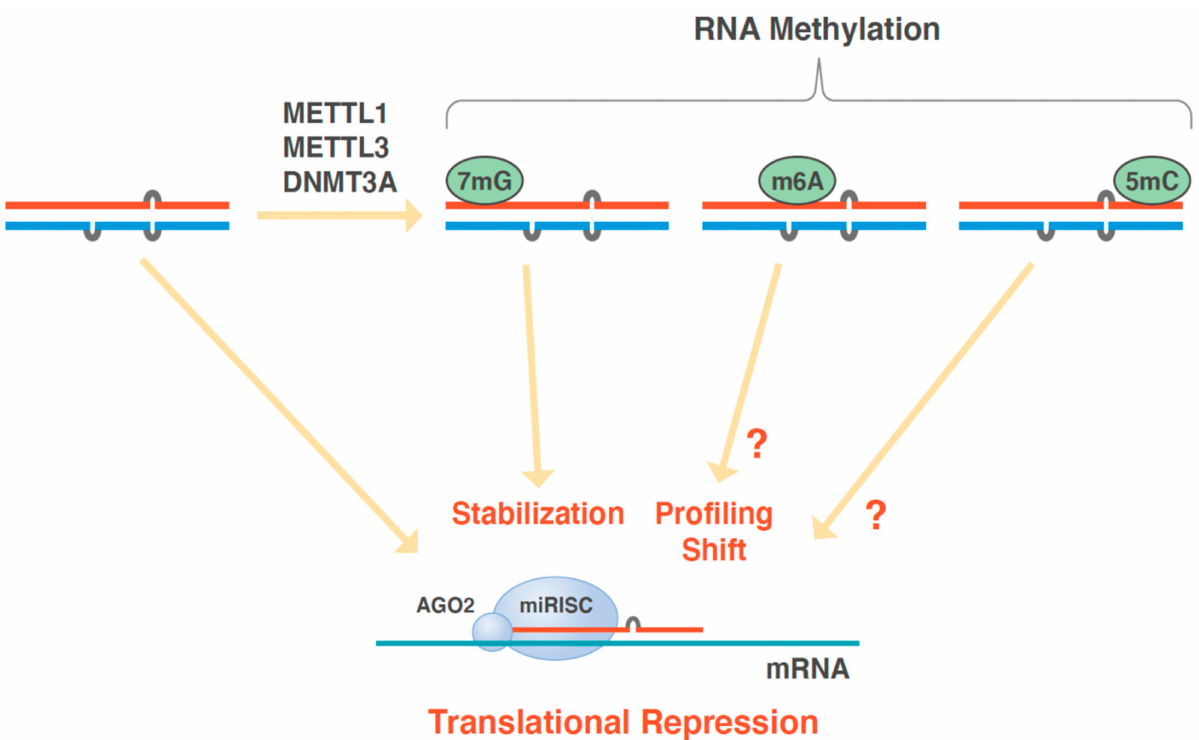
Figure 3. EpisomiR, a subtype of isomiR with different miRNA methylations. Although not fully understood, the methylation of miRNAs modulates miRNA silencing function and mRNA degrada- tion. Recently developed state-of-the-art sequencing techniques, such as tunnel current sequencing and mass spectrometry analysis, enables the detection of m6A and 5mC modifications. 5mC, 5- methylcytosine; AGO2, argonaute RISC catalytic component 2; DNMT3A, DNA methyltransferase 3 alpha; m6A, N6-methyladenosine; m7G, 7-methylguanosine; METTL1, methyltransferase-like protein 1; METTL3, methyltransferase-like protein 3; miRISC, miRNA-induced silencing